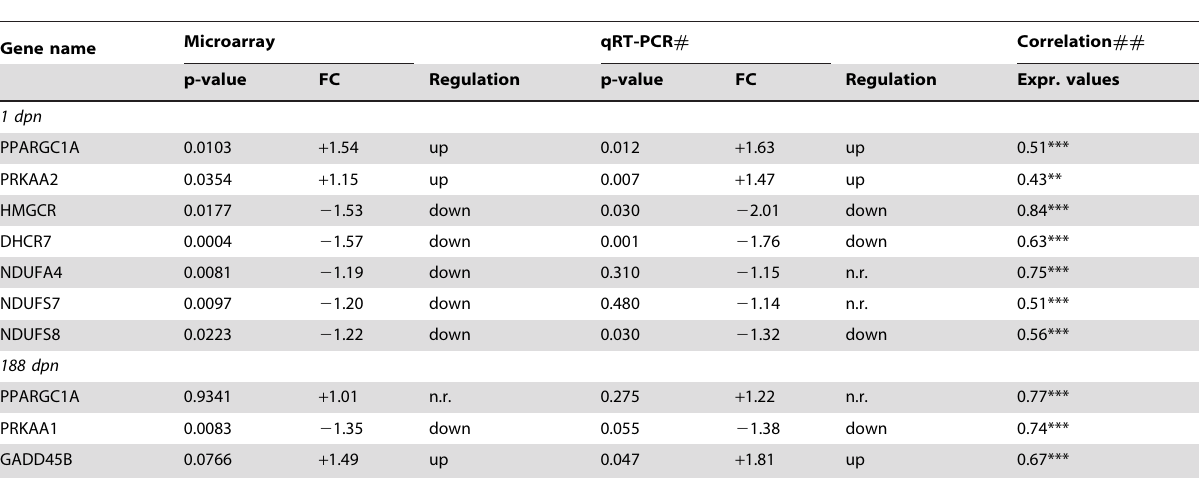
Table 3. Comparison of microarray data and qRT-PCR of selected